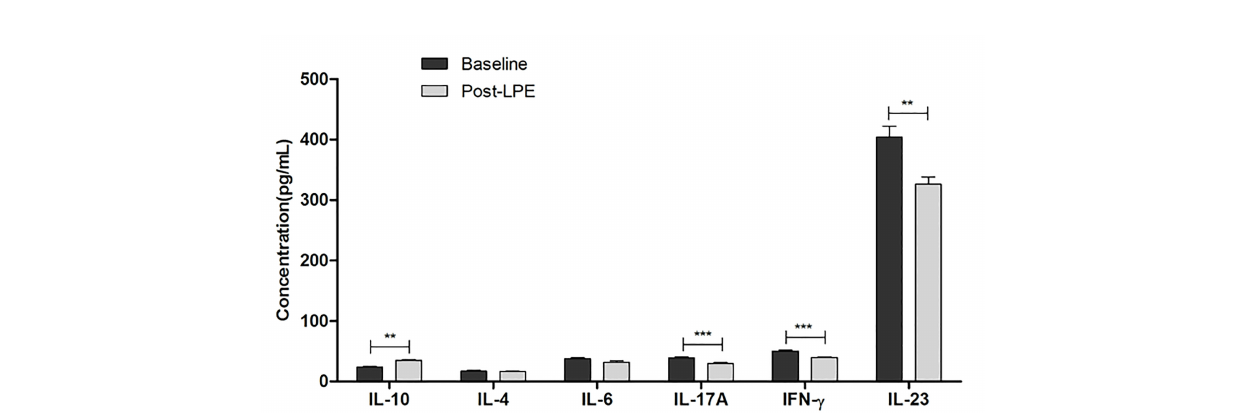
FIGURE 5 | Serum levels of IL-4, IL-10, IL-6, IL-17A, IL-23, and IFN- g before and after LPE therapy were detected in 87 MG patients. Cytokines were detected with ELISA from peripheral blood of MG patients and healthy controls (**p < 0.01, ***p < 0.001). ELISA, enzyme-linked immunosorbent assay; IL, interleukin; IFN, interferon; LPE, lymphoplasma